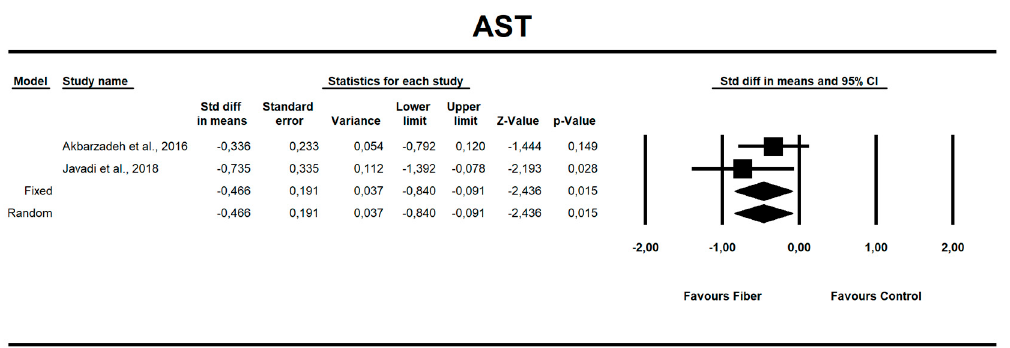
Figure 7. Effect size and standardized mean difference (SMD) for aspartate aminotransferase (AST) in people supplementing fiber vs. controls. Q = 0.958, df(Q) = 1, p = 0.328, I-squared = 0.0.